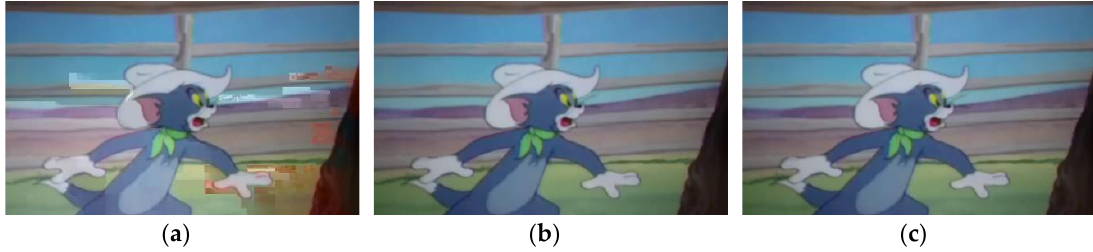
Figure 8. Experimental result diagram: (a) Description of Replication-based scheme; (b) Description of Proposed scheme; (c) Description of Random Linear Network Coding (RLNC)-based scheme.